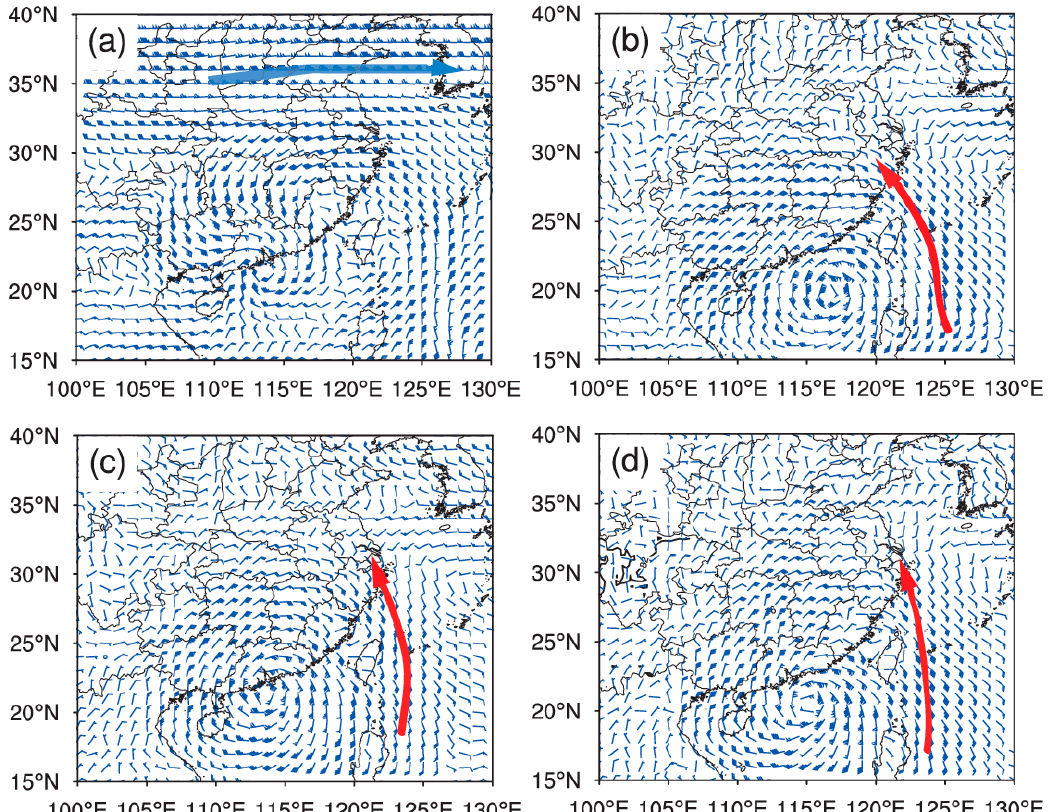
Figure 5. Winds (m · s − 1 ) ( a ) at 200 hPa at 0600 UTC 16 September, at 850 hPa at ( b ) 1800 UTC 15 September and ( c ) 0600 UTC 16 September, and ( d ) at 925 hPa at 0000 UTC 16 September 2018. Blue arrow in ( a ) denotes the upper-level jet and red arrows in ( b – d ) denote the low-level jets.